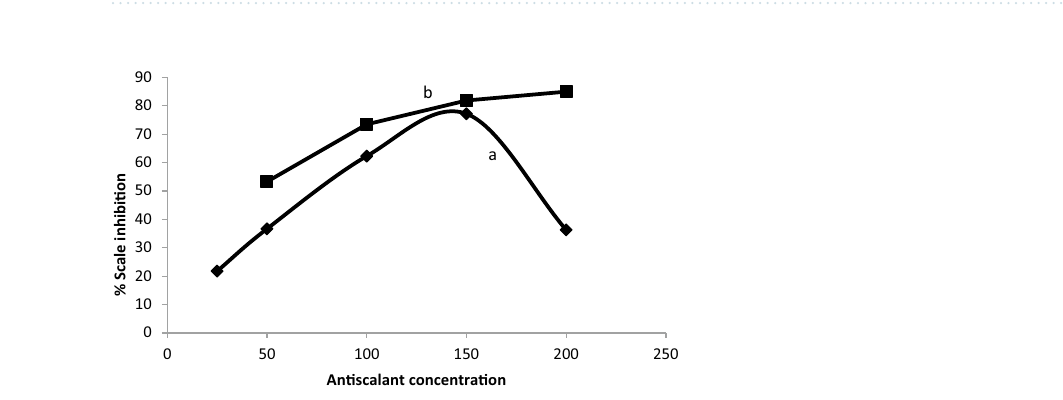
Figure 15. Impedance spectra of polarized steel in brine solution with its fitting curves and equivalent used circuits in the absence and presence of scale inhibitors.